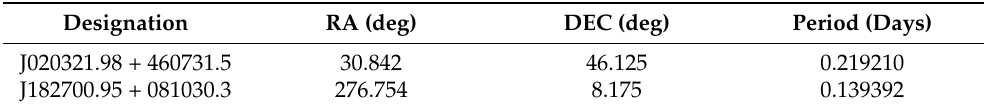
Table 4. Phase folding diagram of two of the white dwarf binary candidates with obvious light curve periods.